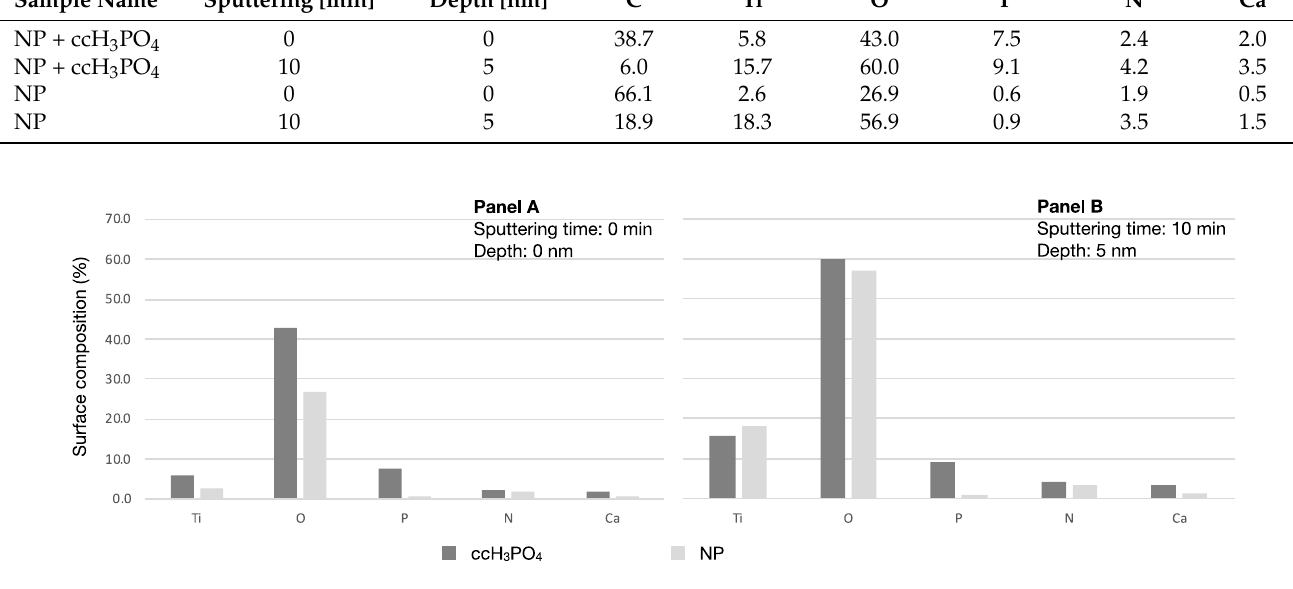
Figure 2. Proportion of elements on the untreated control and the ccH 3 PO 4 -treated NP surfaces. Panel A shows that the concentrations of phosphorus and oxygen are higher on the ccH 3 PO 4 -treated NP surface than on the untreated control. Panel B shows that the proportion of phosphorus did not change on the control or on the ccH 3 PO 4 -treated NP surfaces after sputtering. Carbon concentration is intentionally omitted because it would have caused the visualization of the other elements to be difficult (see Table 3 for data).